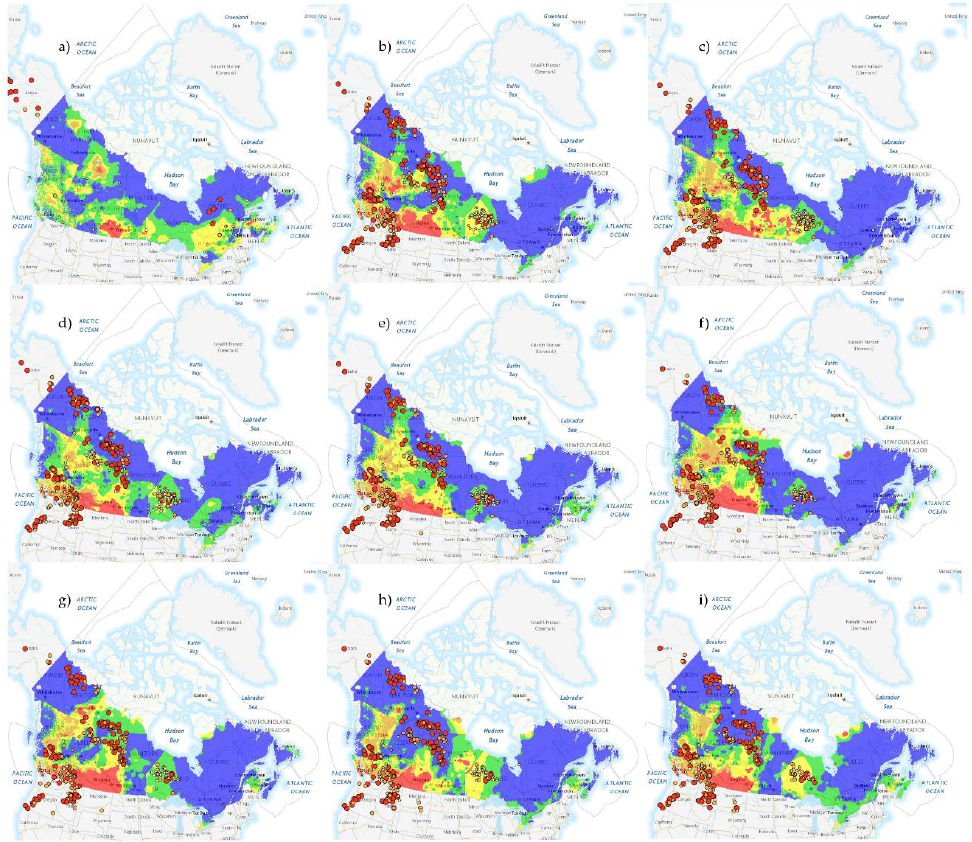
Figure 1. Daily active fire and fire danger hotspots provided by the Canadian Wildland Fire Information System based on the AVHRR, MODIS and VIIRS satellite observations for 13 June ( a ), 19 August ( b ), 20 August ( c ), 21 August ( d ), 22 August ( e ), 23 August ( f ), 24 August ( g ), 25 August ( h ), and 26 August ( i ) of 2017. Active Fires: 0 to 100 Ha (small yellow dots), 101 to 1000 Ha (medium orange dots), > 1000 Ha (big red dots). Fire Danger: Low (blue areas), Moderate (green areas), High (yellow areas), Very High (orange areas), Extreme (red